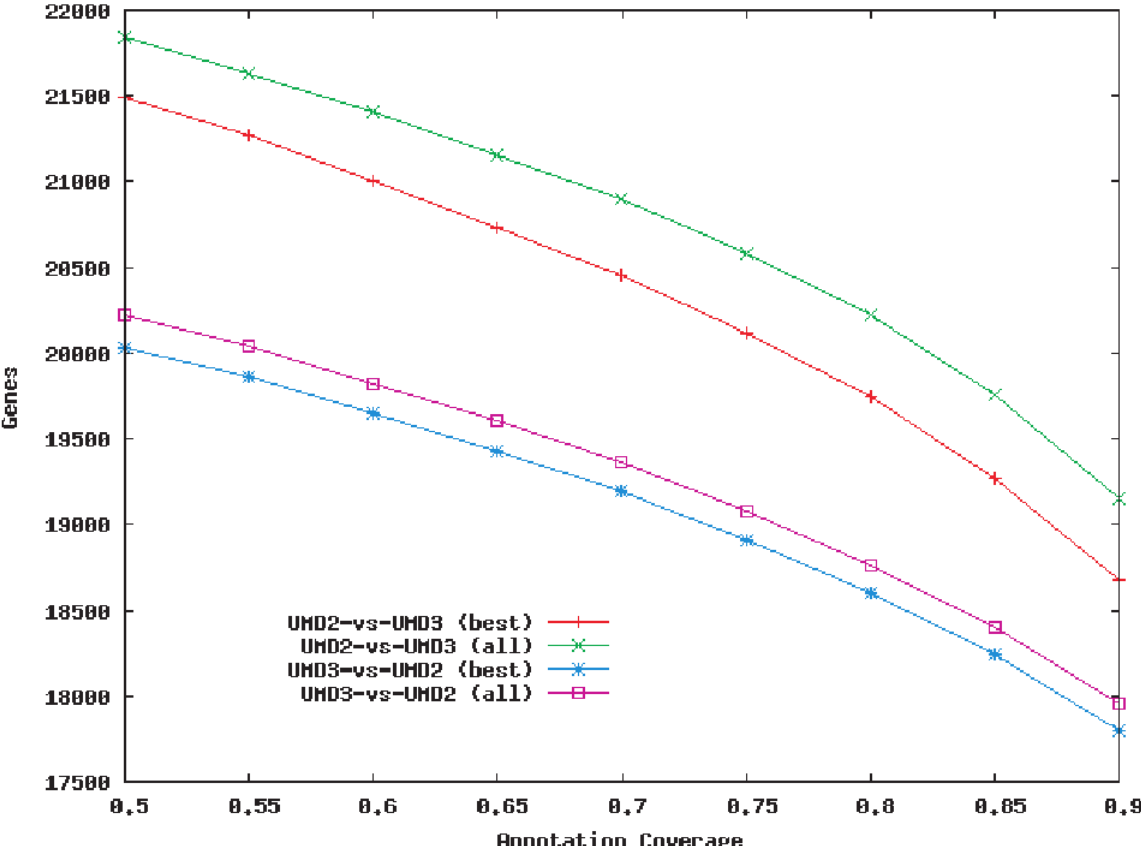
Figure 2. Agreement between gene annotations in the UMD2 and UMD3 assemblies. Plotted values represent the numbers of genes in one annotation that overlap the other annotation by a fraction x or more of their length, when all (‘all’) and when only the best (‘best’) alignments of a transcript are included. The total number of annotated protein-coding genes is 23,221 for UMD2, and 21,342 for UMD3.